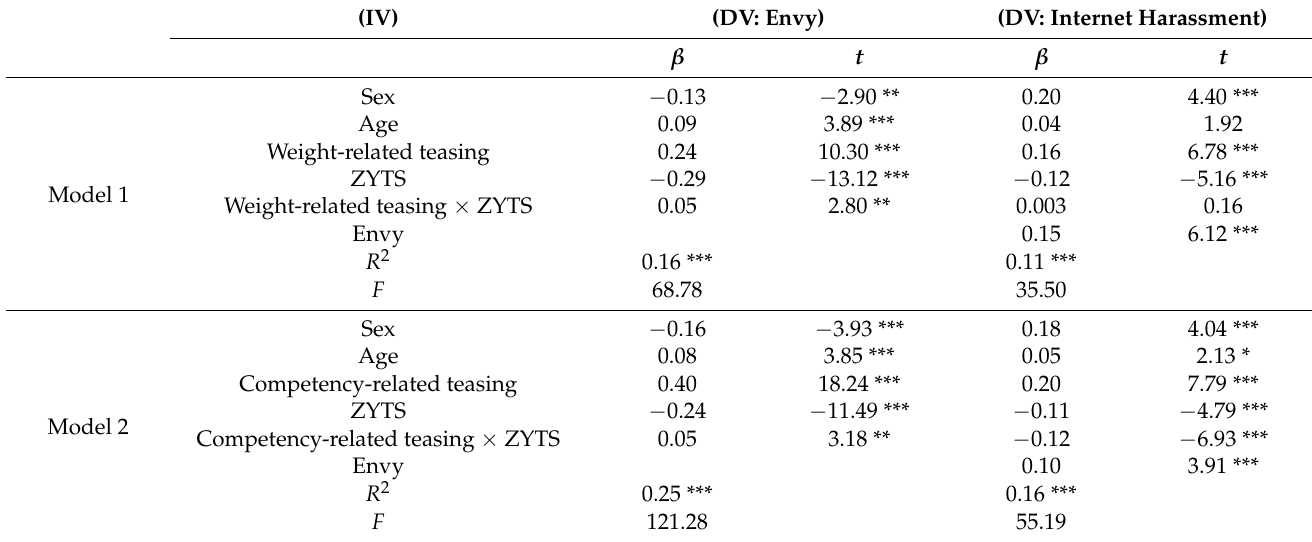
Table 3. Testing the moderated mediation effect of weight-related/competency-related teasing on Internet